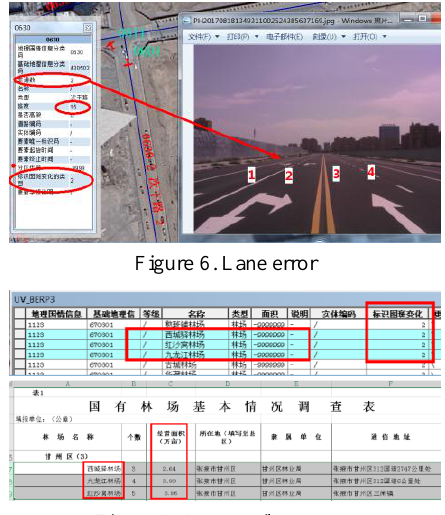
Figure 7. Area attribute